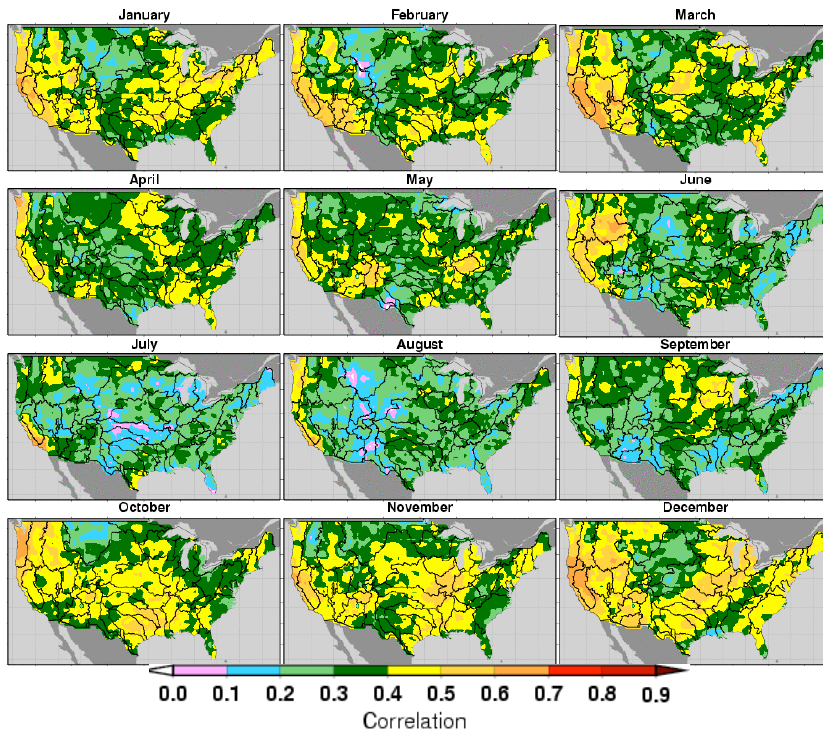
Figure 2: Correlation between observed and forecasted (MRF) 14-day accumulated 3 Fig. 2. Correlation between observed and forecasted (MRF) 14-day accumulated precipitation during each precipitation during each month. 4